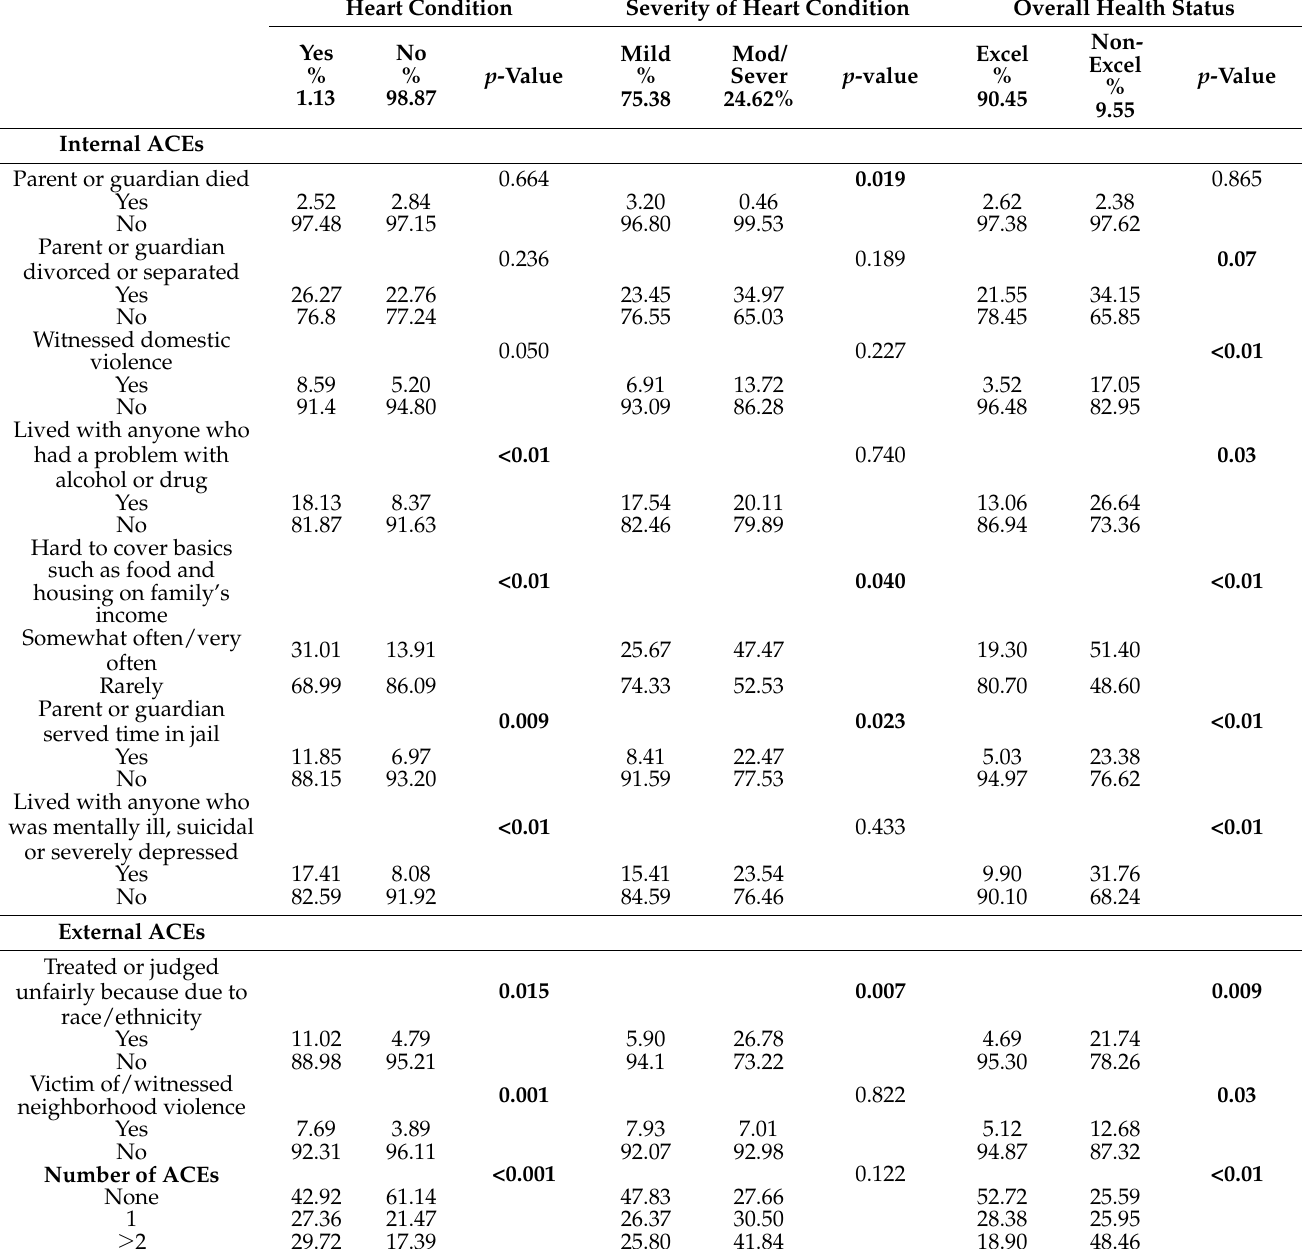
Table 2. Bivariate analyses of ACEs with heart conditions, severity of heart condition, and overall health